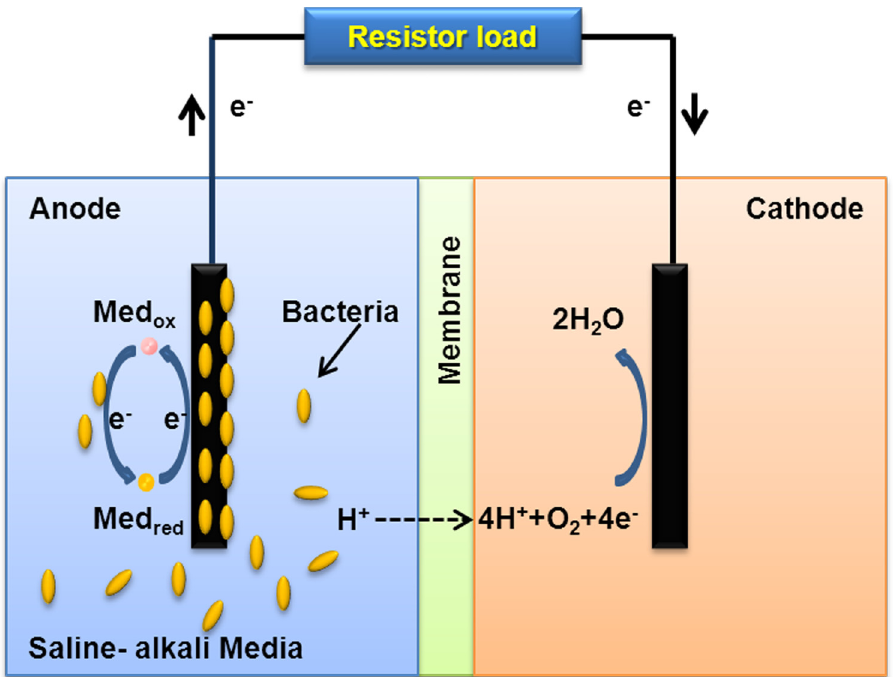
Fig 1. Schematic illustration of two-chambered MFC for bioelectricity